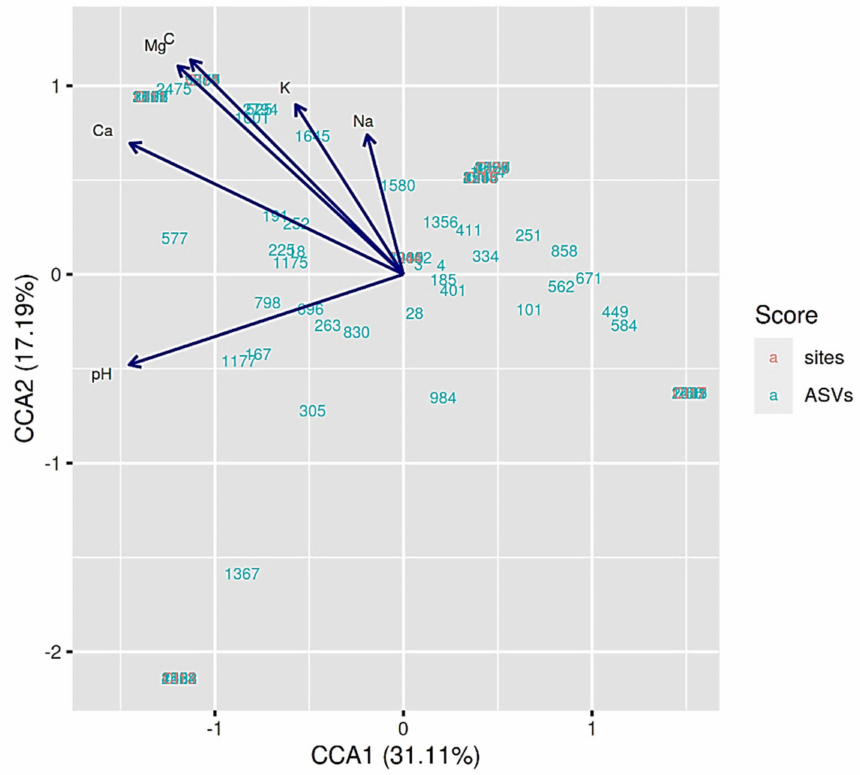
Figure 6. Canonical correspondence analysis (CCA) showing the relationship between the 77 ASVs of rhizobia (represented by their number) and the physico-chemical parameters of soils from Northern C ô te d’Ivoire. The arrows represent soil